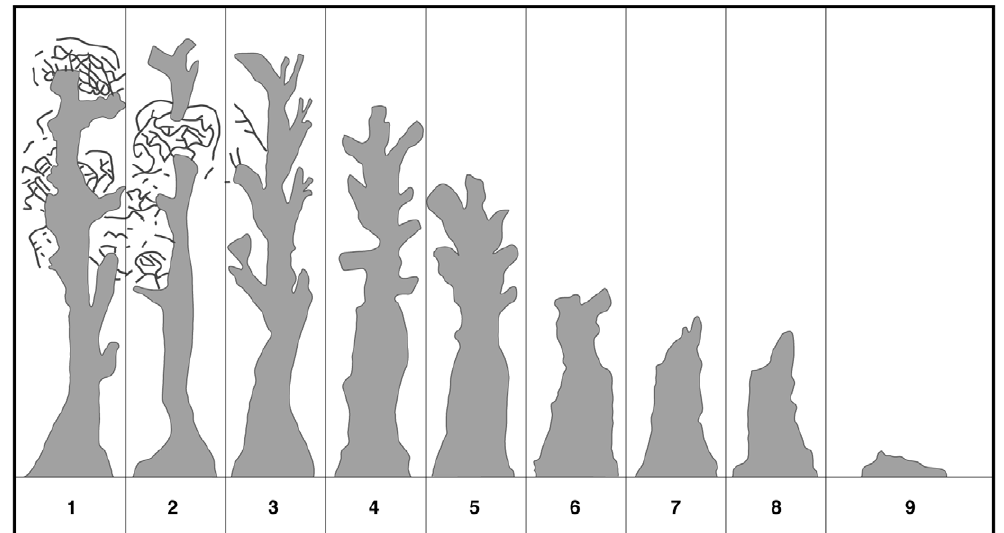
Figure 2. Sequential development of tree forms in Mountain Ash trees. Form 1: Mature, living tree; Form 2: Mature living trees with a dead or broken top; Form 3: Dead tree with most branches still intact; Form 4: Dead tree with 0–25% of the top broken off; branches remaining as stubs only; Form 5: Dead tree with top 25–50% broken away; Form 6: Dead tree with top 50–75% broken away; Form 7: Solid dead tree with $ 75% of the top broken away; Form 8: Hollow stump. In subsequent surveys we added a ninth category – Form 9: Collapsed tree.